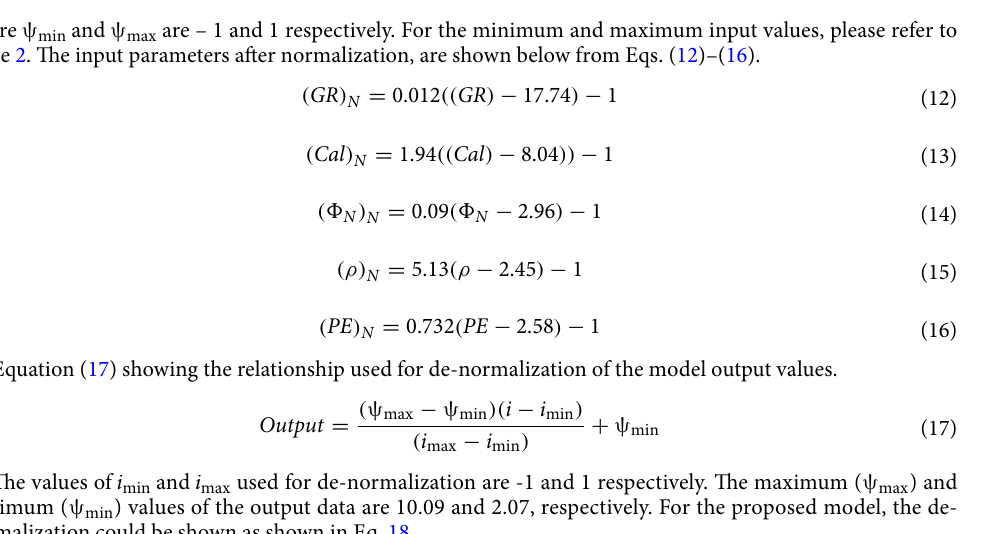
The values of i min and i max used for de-normalization are -1 and 1 respectively. The maximum ( ψ max ) and minimum ( ψ min ) values of the output data are 10.09 and 2.07, respectively. For the proposed model, the de- normalization could be shown as shown in Eq. 18.